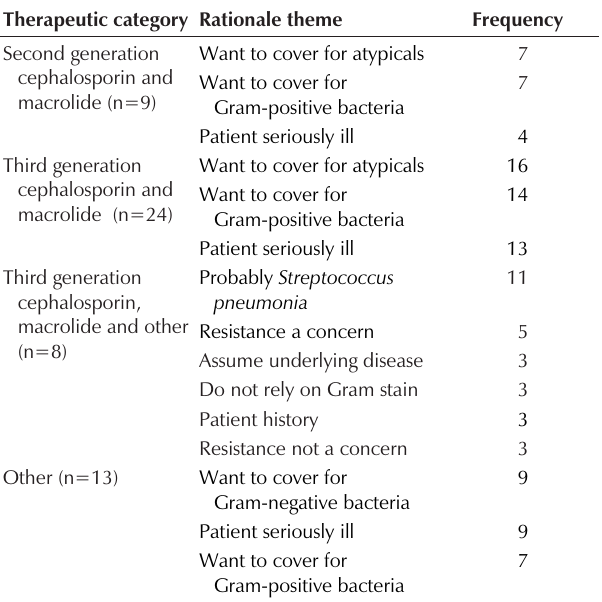
Three most commonly occurring rationale themes in case 3 (open-ended questionnaires) by therapeutic